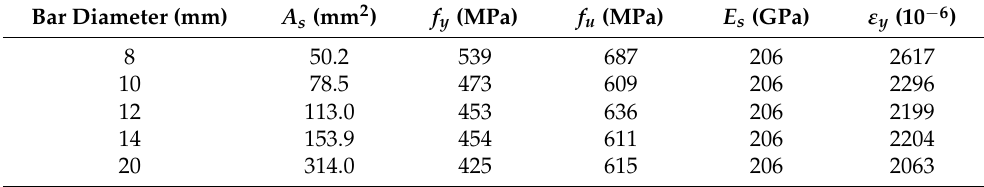
Table 3. Reinforcement properties.